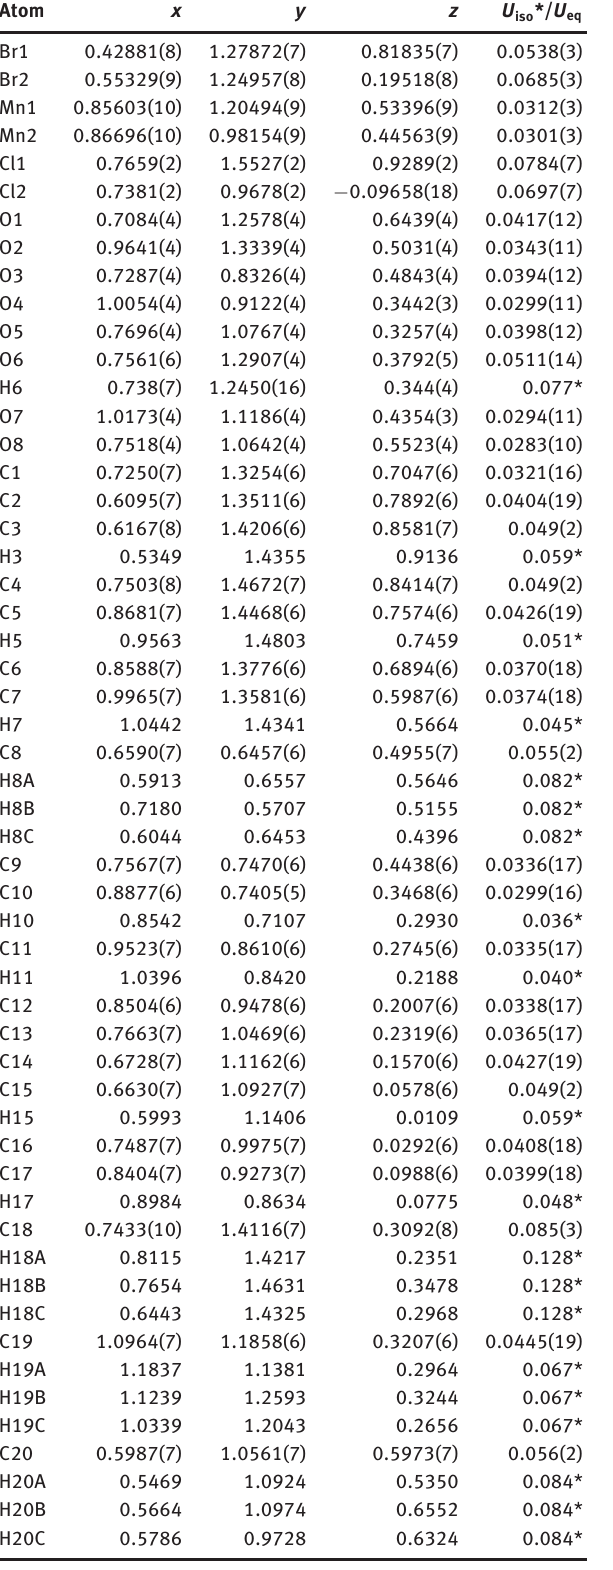
Table 2: Fractional atomic coordinates and isotropic or equivalent isotropic displacement parameters (Å 2